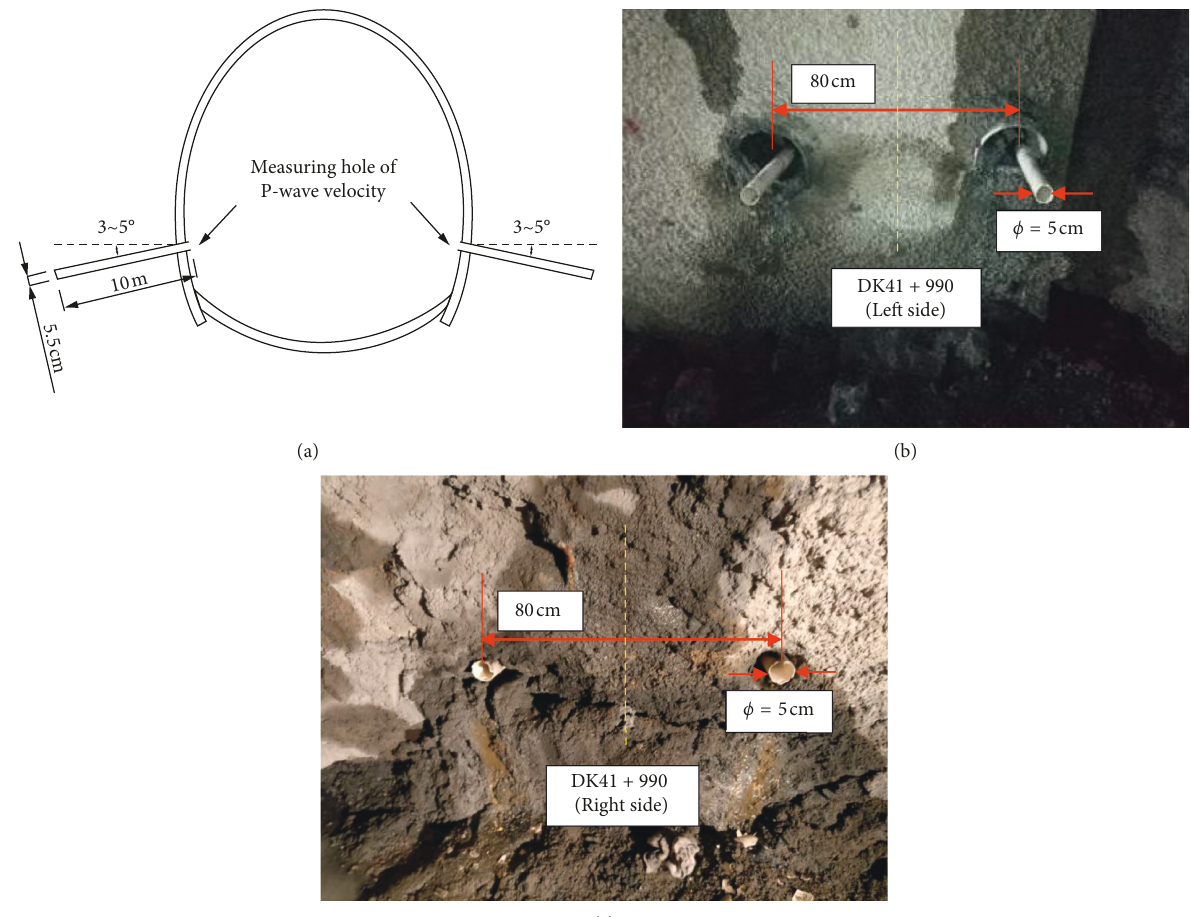
Figure 4: Arrangement of measuring points of the broken rock zone test.